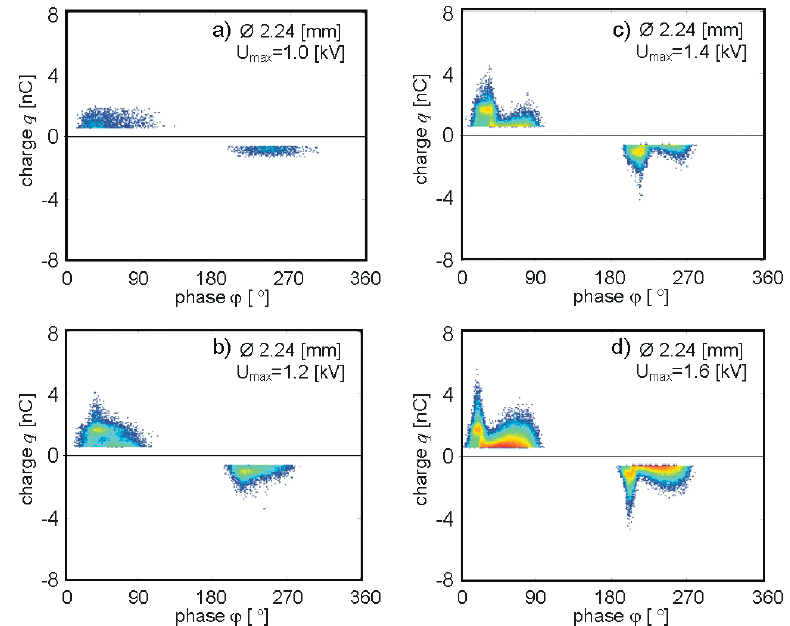
Figure 22. The PRPD patterns acquired for TP2 sample at four test voltage values: ( a ) U max = 1.0 kV; ( b ) U max = 1.2 kV; ( c ) U max = 1.4 kV; ( d ) U max = 1.6 kV.